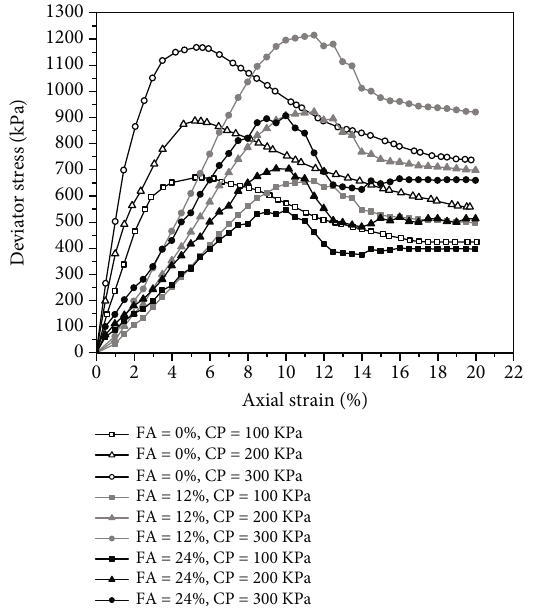
Figure 14: Stress-strain curves ( FT = 60 , L = 6 %